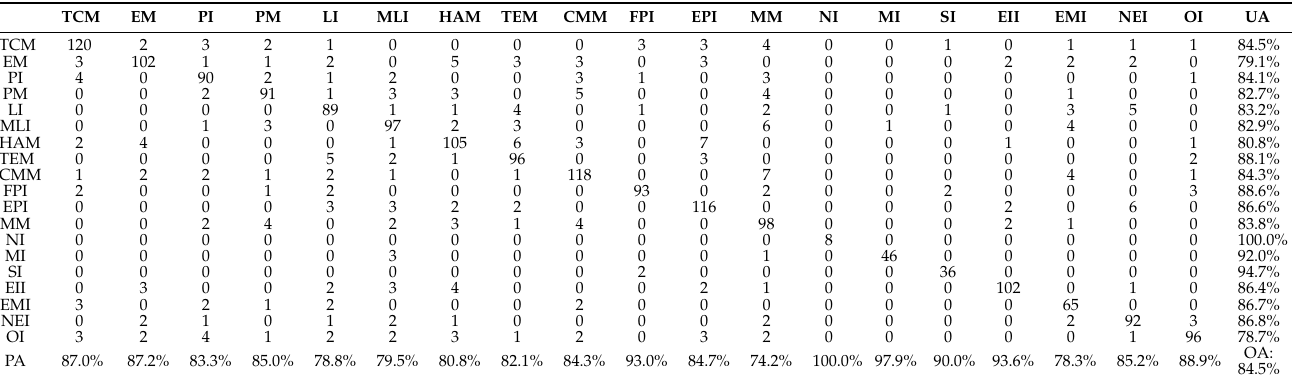
Table A1. Confusion matrix of industrial land use